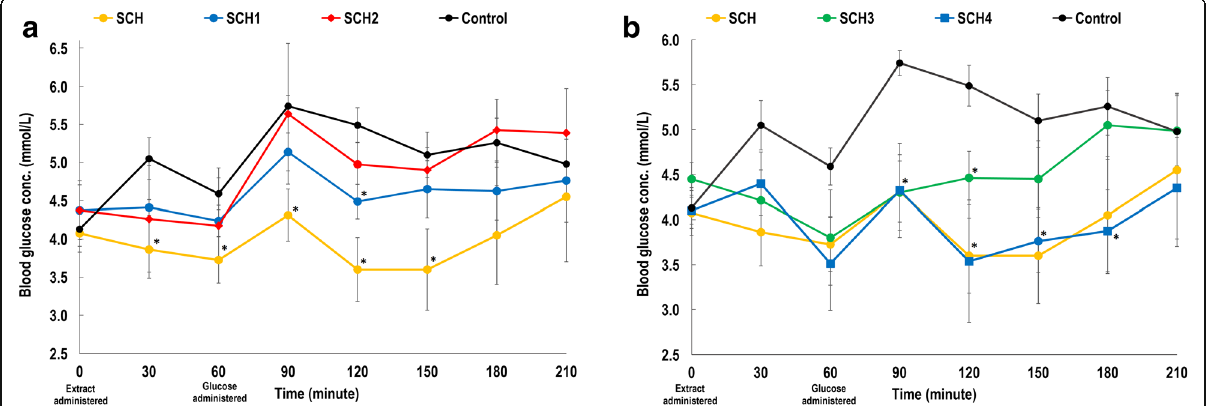
Fig. 1 a Effect of Smilax canellifolia rhizomes hexane crude extract (SCH; 50 mg/kg BW) and sub-fractions (SCH1 – SCH2; 25 mg/kg BW) on blood glucose concentration. Data expressed as mean ± SEM ( n = 5); * represents p < 0.05 vs control. b. Effect of SCH (50 mg/kg BW) and sub-fractions (SCH3 – SCH4; 25 mg/kg BW) on blood glucose concentration. Data are mean ± SEM ( n = 5); * represents p < 0.05 vs